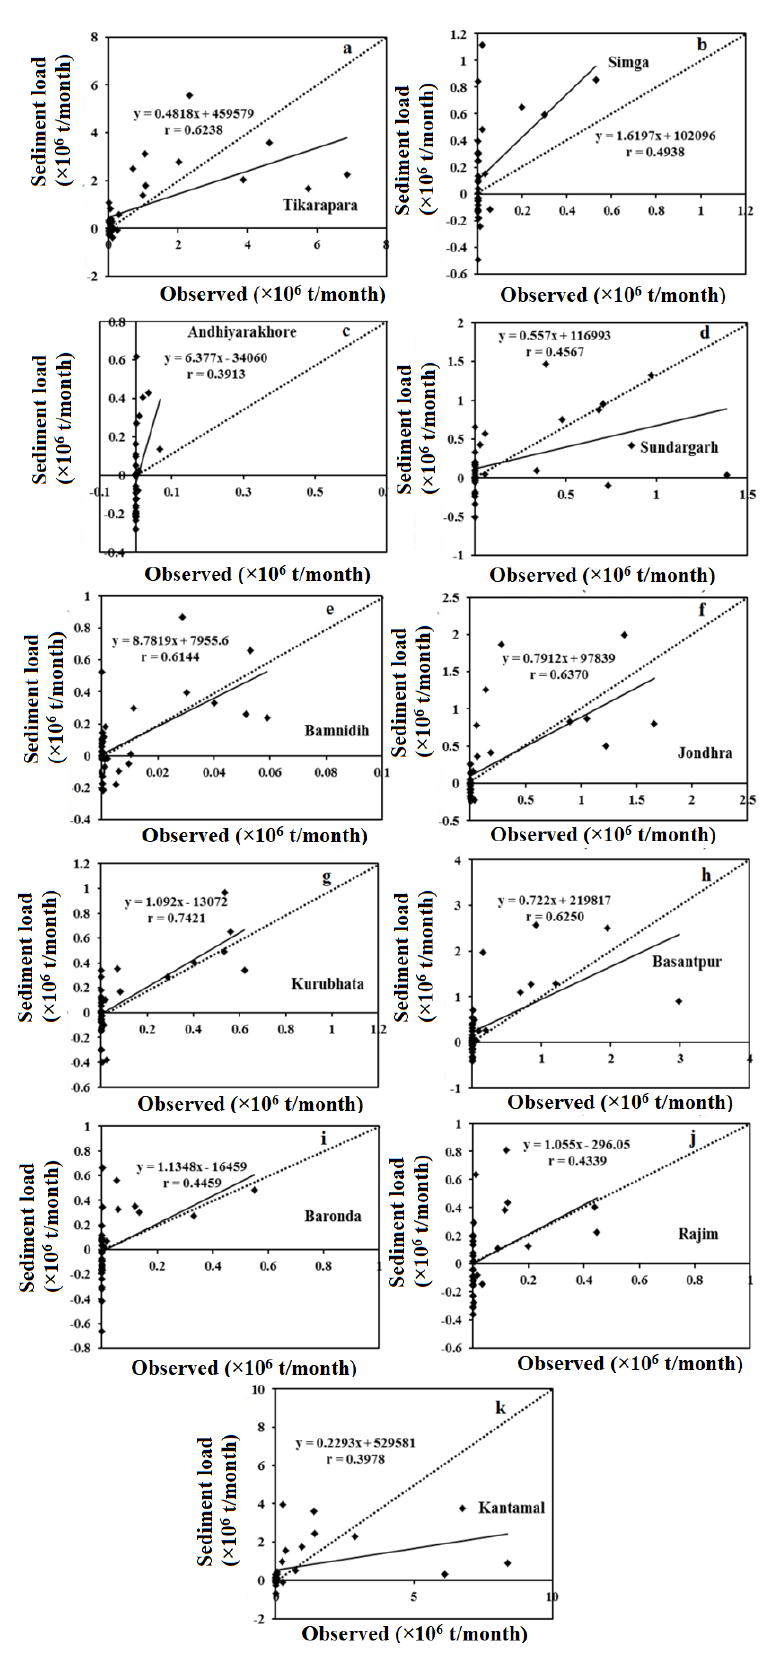
Figure 12. Scatter plot of the actual and forecasted SL of the MAR forecasting model during the testing phase (a-k).